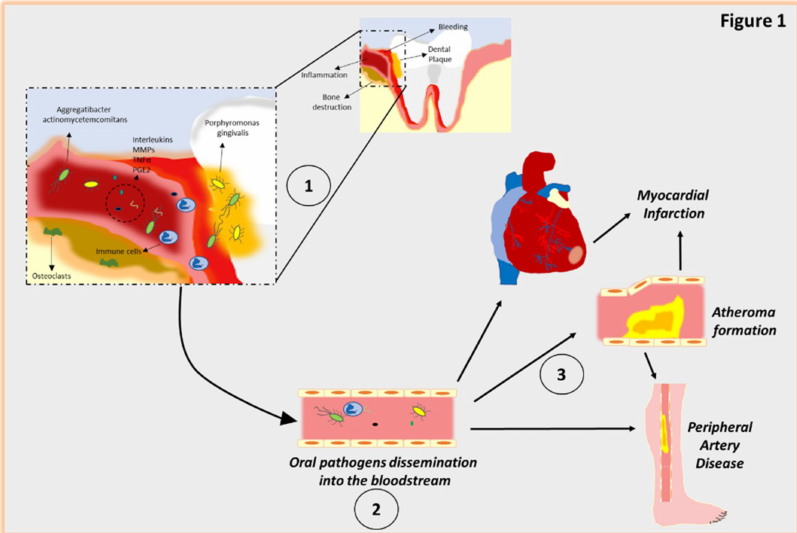
Figure 1. Schematic representation of inflammatory mechanisms linking periodontitis to CVDs. (1) The imbalance in pathogens of the biofilm leads to gingival epithelium inflammation that releases chemical mediators, such as interleukins (ILs), prostaglandin E2 (PGE2), tumor necrosis factor alpha (TNF- α ) and MMPs, that recruit immune cells. This inflammatory response induces alveolar bone reabsorption, by osteoclasts. (2) At a chronic stage, oral pathogenic dissemination into the bloodstream leads to the onset of CVDs including atherosclerosis, myocardial infarction and peripheral artery disease